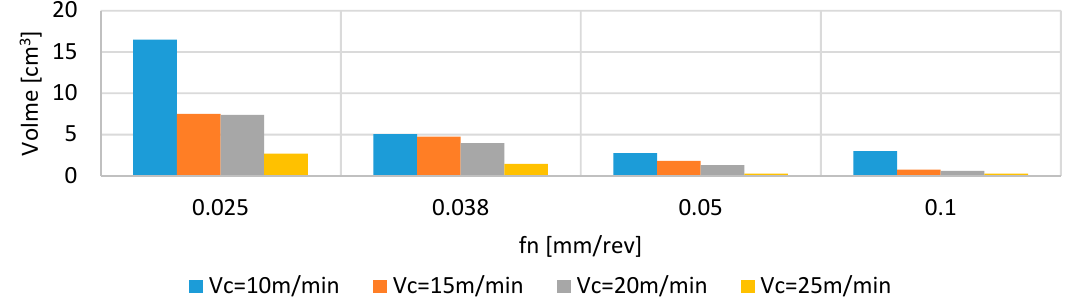
Figure 5. Machined volume for drilling of the TNB alloy (up), ingot MoCuSi alloy (middle), and extruded MoCuSi alloy (down).